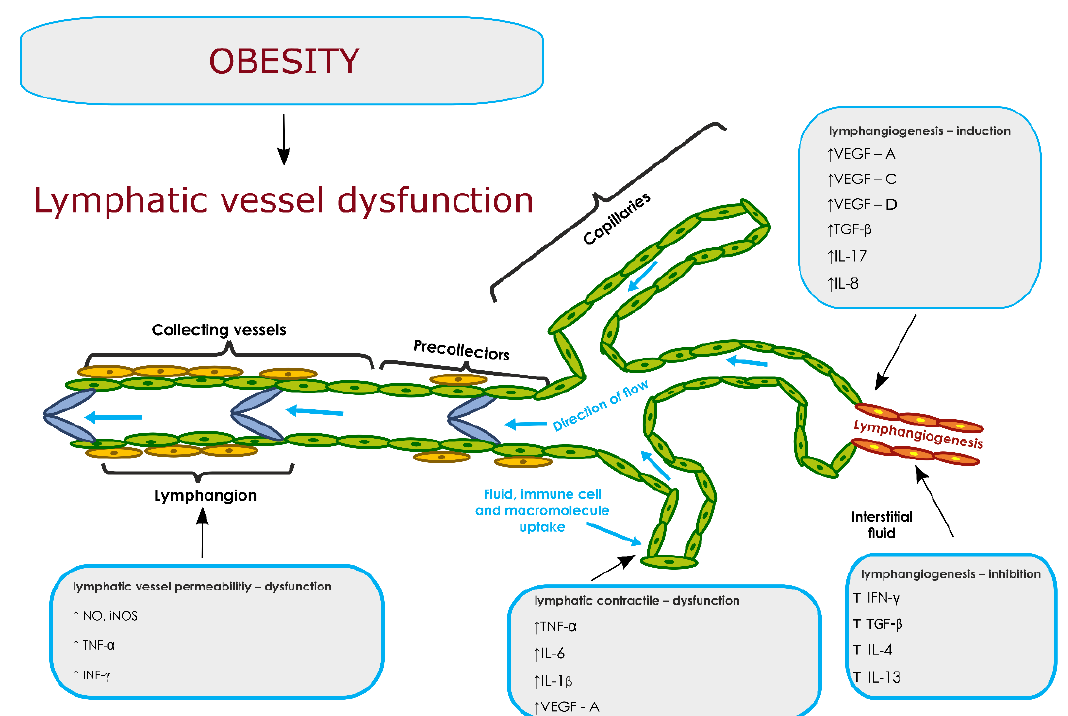
Figure 3. The possible influence of pro- and anti-lymphangiogenic factors in the dysfunction of the lymphatic system